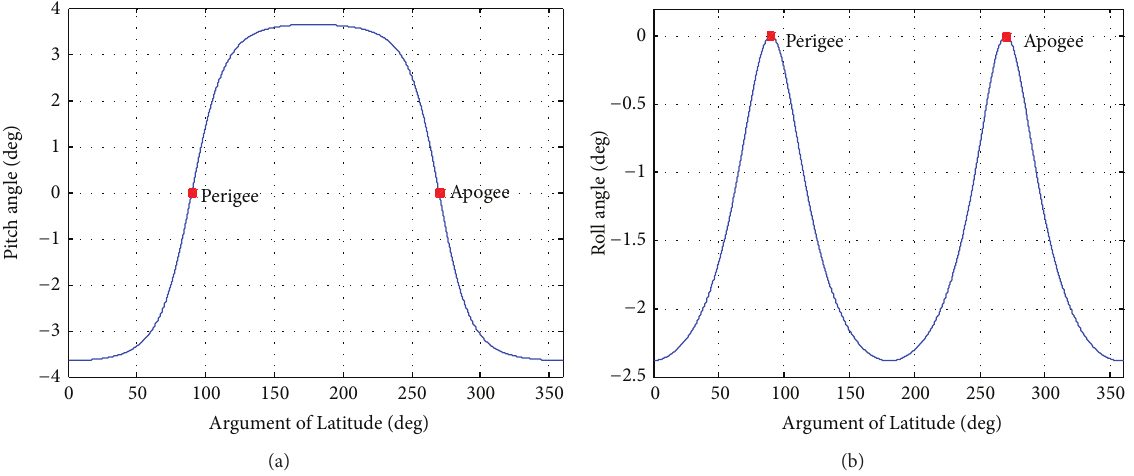
Figure 4: The pitch angles and the roll angles of the 2D method along the orbit.